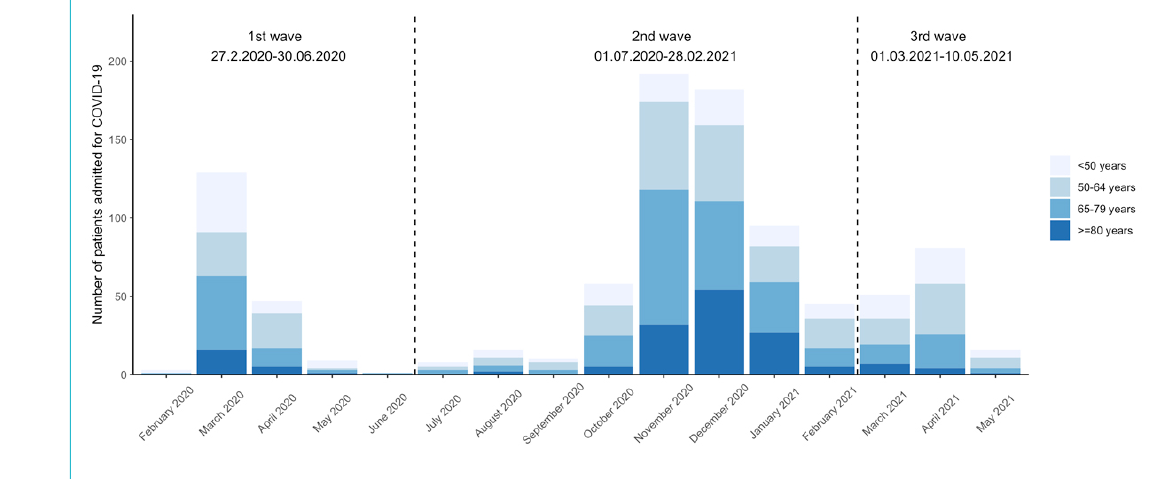
Figure 1: Hospital admission at the University Hospital of Basel between February 2020 and May 2021 stratified by age. The dashed lines in- dicate the first, second and third